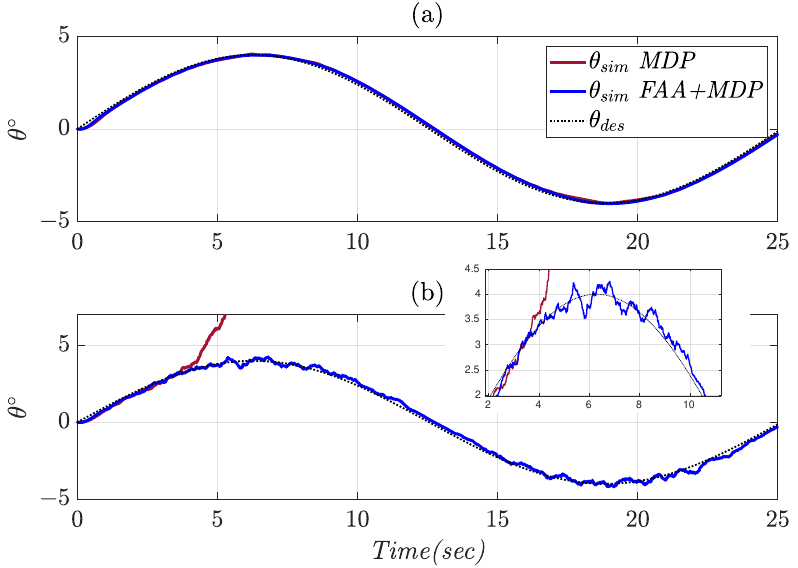
Figure 8. Variable θ tracking using MDP and FAA-improved MDP ( a ) in ideal conditions, ( b ) in the presence of sensor measurement noises and atmospheric